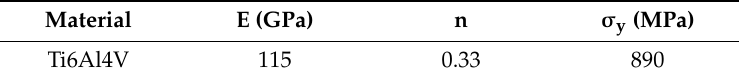
Table 2. Main mechanical properties of the titanium alloy Ti6Al4V